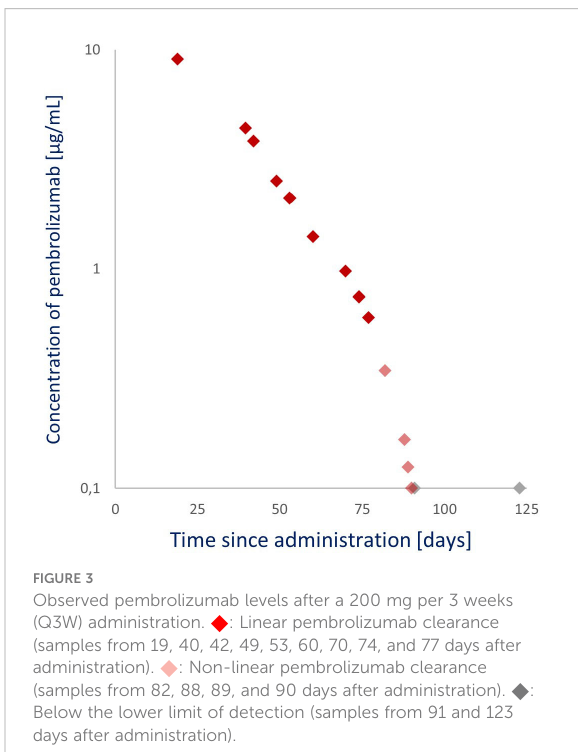
FIGURE 3 Observed pembrolizumab levels after a 200 mg per 3 weeks (Q3W) administration. ◆ : Linear pembrolizumab clearance (samples from 19, 40, 42, 49, 53, 60, 70, 74, and 77 days after administration). ◆ : Non-linear pembrolizumab clearance (samples from 82, 88, 89, and 90 days after administration). ◆ : Below the lower limit of detection (samples from 91 and 123 days after